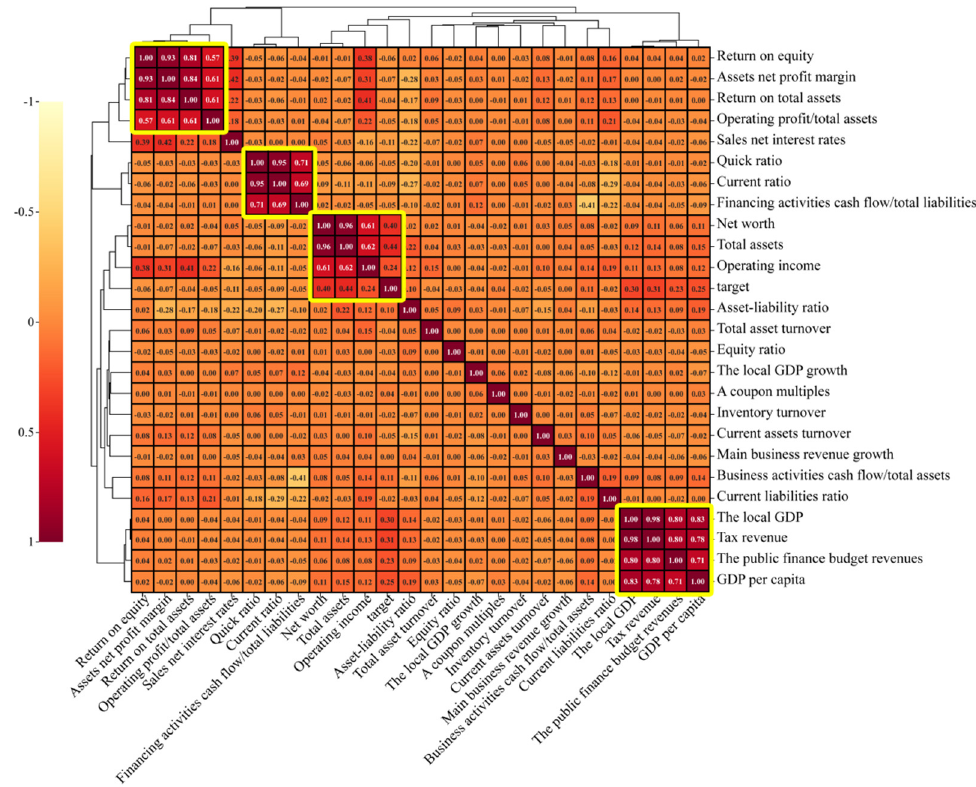
Figure 3. Correlation matrix analysis of variables.